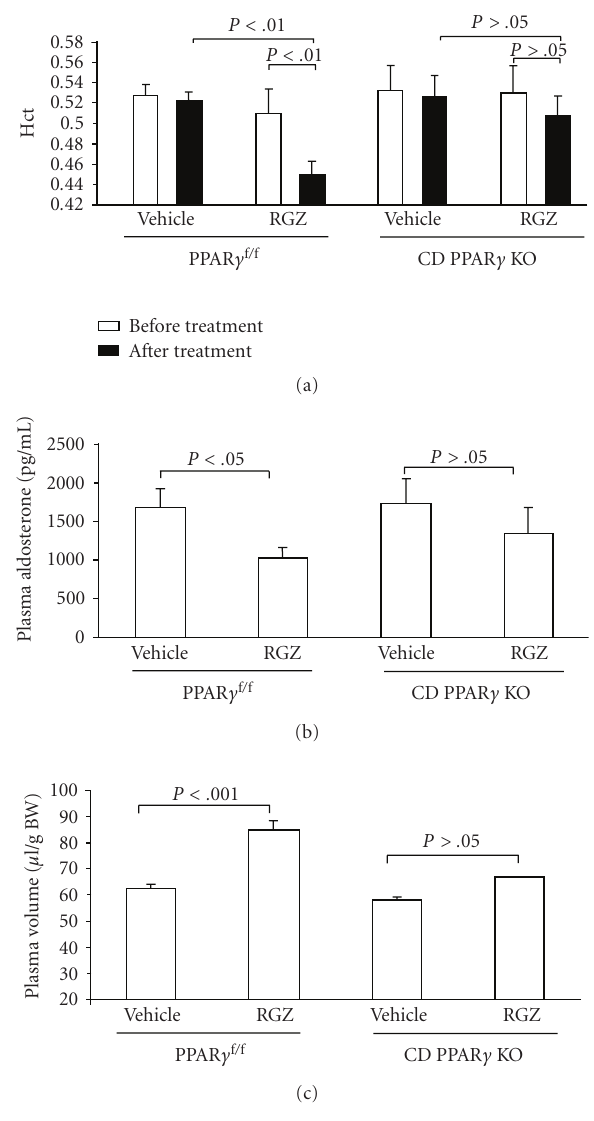
Figure 2: Changes in plasma volume in PPAR γ f / f and CD PPAR γ knockout mice following rosiglitazone (RGZ) treatment (adapted from [28]). (a) Hematocrit (Hct) in PPAR γ f / f and CD PPAR γ knockout mice before and after RGZ treatment. (b) Plasma aldosterone levels in PPAR γ f / f and CD PPAR γ knockout mice following RGZ treatment. (c) Determination of plasma volume in PPAR γ f / f and CD PPAR γ KO mice by the Evans blue (EB) dye